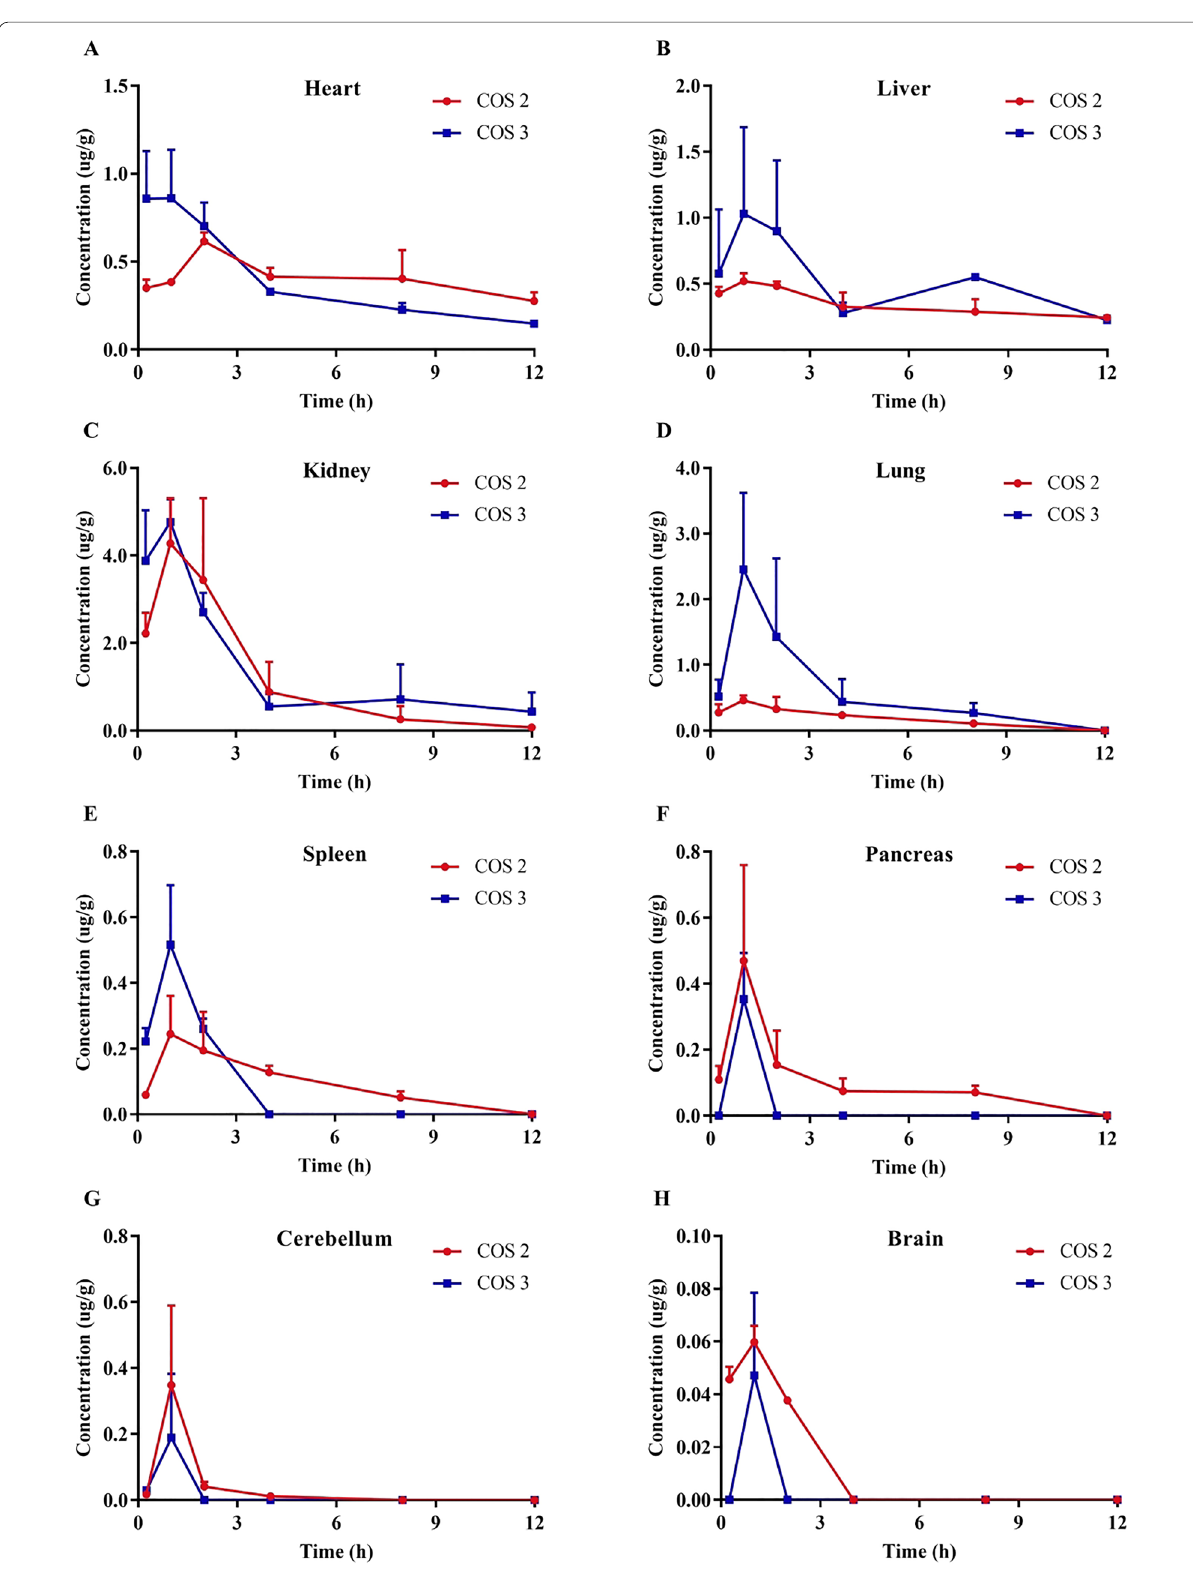
Fig. 4 Distribution of COS 2 and COS 3 in various tissues after intragastric administration ( A -heart, B -liver, C -kidney, D -lung, E -spleen, F -pancreas, G- cerebellum, H -brain; n =